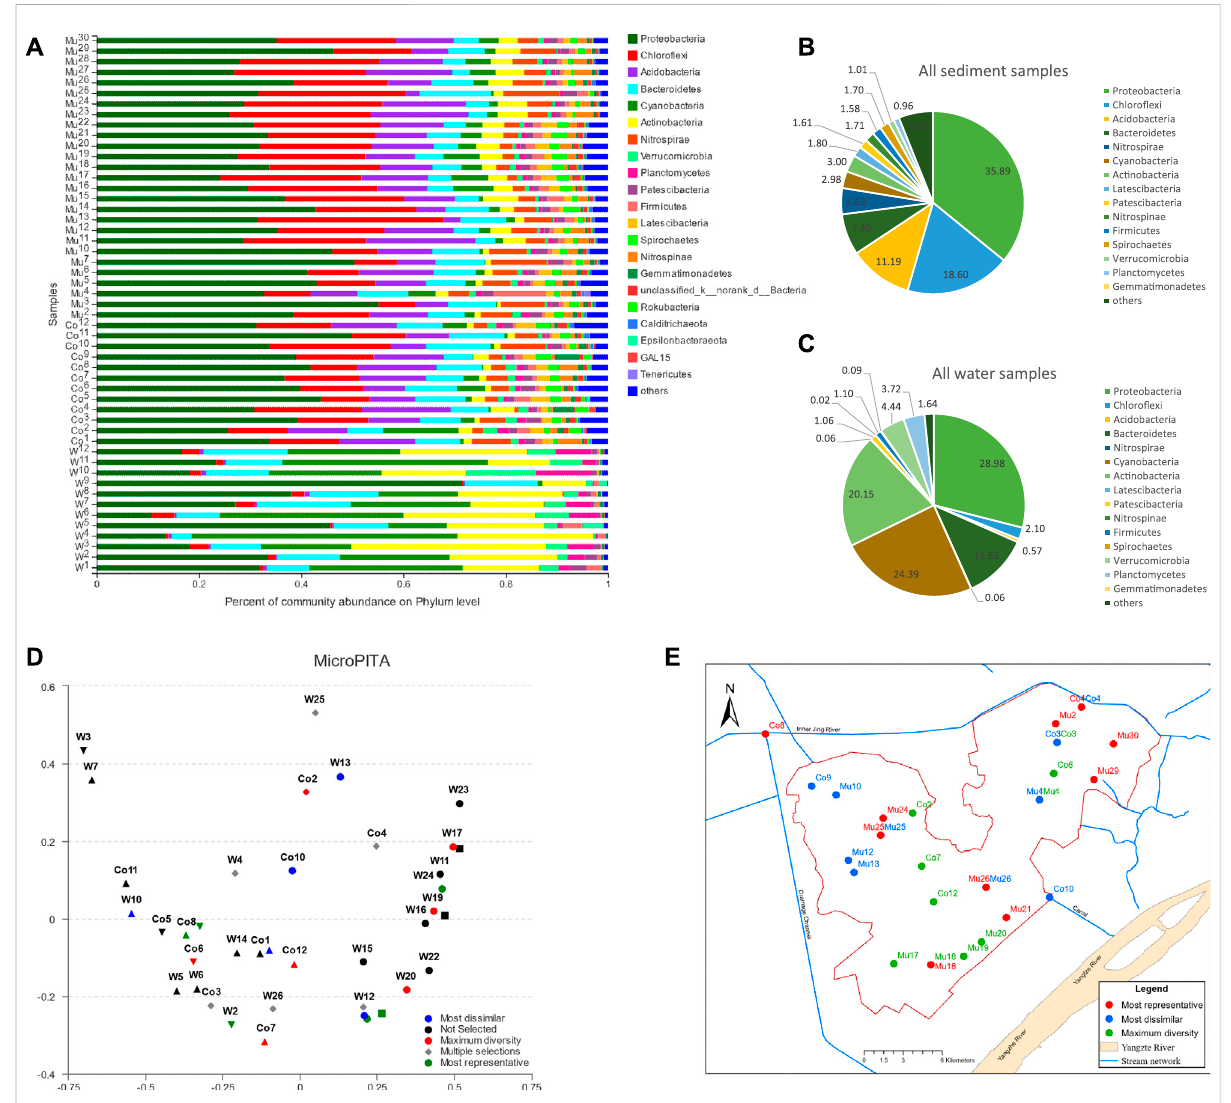
FIGURE 2 Compositionofmicrobialcommunitiesinwaterandsedimentsamples: (A) phylawithrelativeabundancegreaterthan1%inwaterandsediment samples, (B) percentages of phyla with average relative abundance greater than 1% in all sediment samples, (C) percentages of phyla with average relative abundance greater than 1%in all water samples, (D) themostdissimilar, maximum diversity and mostrepresentative samples identi fi edusing MicroPITA analysis, (E) distribution of identi fi ed samples from MicroPITA